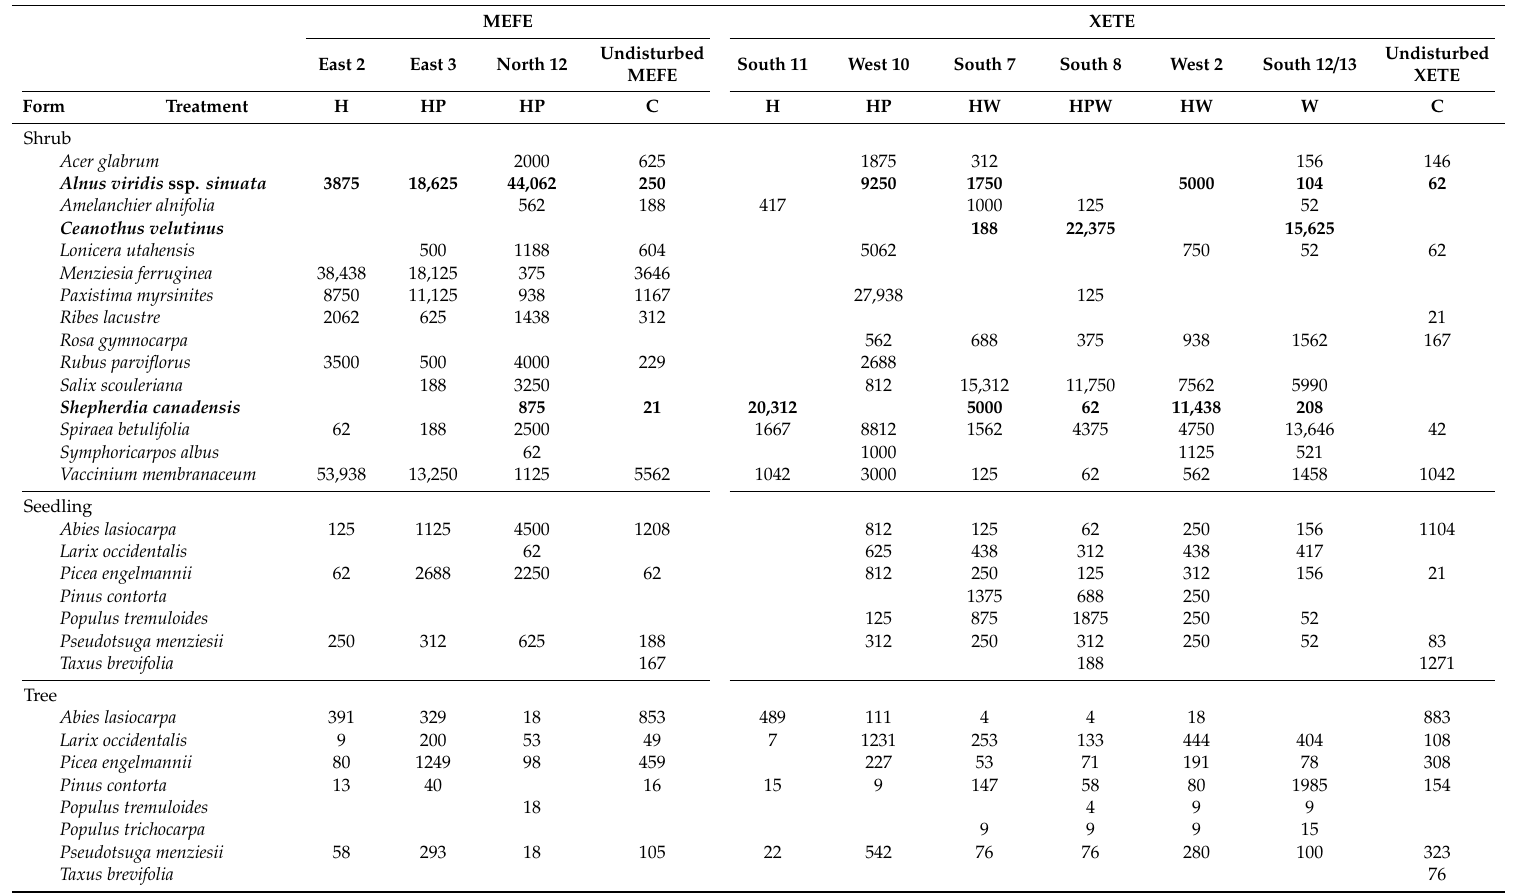
Table 3. Thirty-year post-treatment measures of the total live stems ha − 1 of shrubs, tree seedlings, and trees for the two phases ( Menziesia ferruginea , MEFE; Xerophyllum tenax , XETE) of the Abies lasiocarpa / Clintonia uniflora habitat type [50] and the subsequent 11 disturbance categories for the Miller Creek Demonstration Forest, Montana, USA (see Table 1 for descriptions). For treatments: H = harvested; P = prescribed fire; W = wildfire; C = control. N-fixing plants shown in